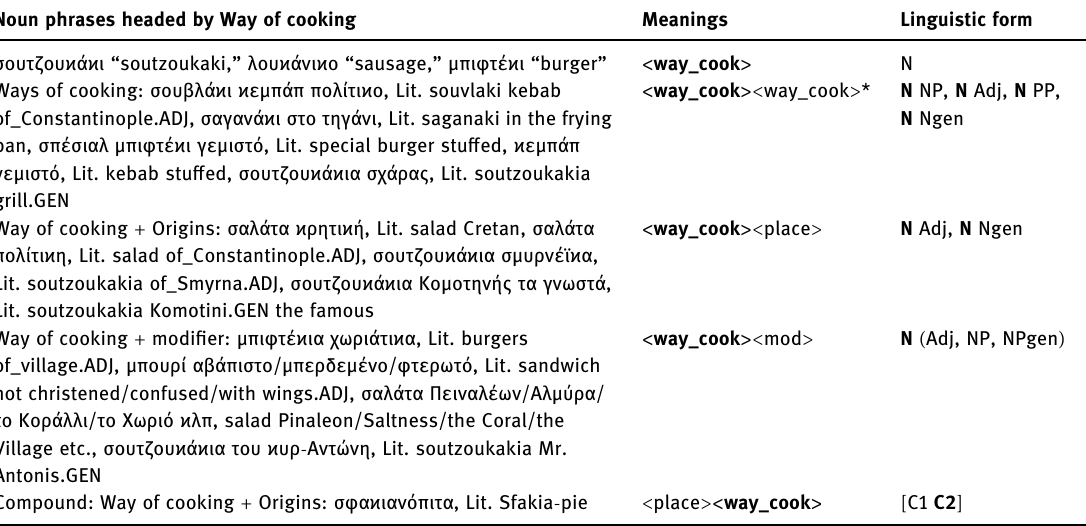
Table 8: The dish name is headed by a noun denoting the way of preparation. No MI is supplied Noun phrases headed by Way of cooking Meanings Linguistic form σουτζουϰάϰι “ soutzoukaki, ” λουϰάνιϰο “ sausage, ” μπιφτέϰι “ burger ” < way_cook >